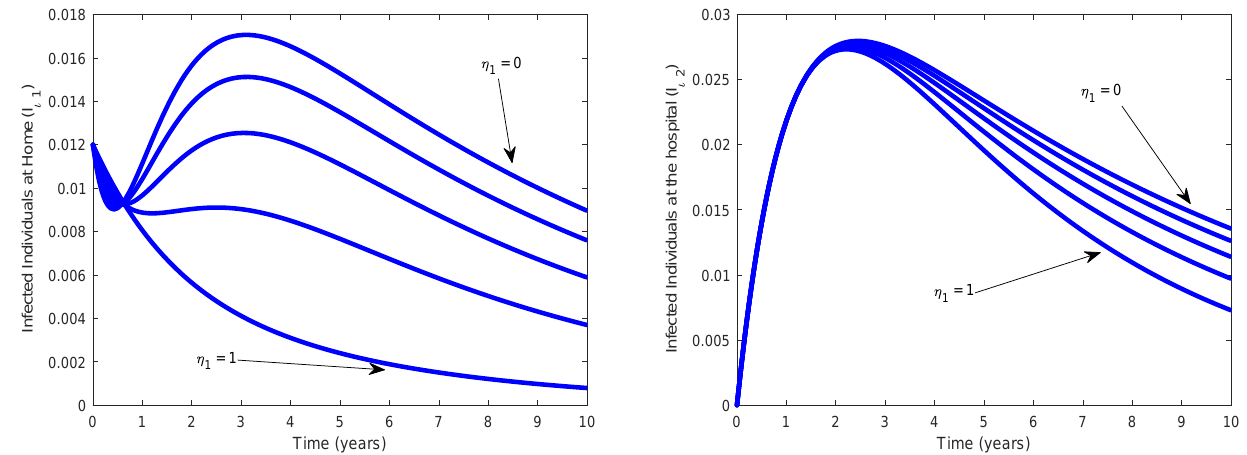
Figure 8. Impact of progression rate ( η 1 ) from I ι 1 to I ι 2 on I ι 1 , and I ι 2 , varying η 1 . Other parameters are given as Λ = 450,862, β = 0.86, ν = 0.25, φ = 0.2, σ = 0.65, z = 0.11, µ = 0.02041, ψ = 0.5, η 1 = 0.02, η 2 = 0.02, γ 1 = 0.5, γ 2 = 0.6, κ 1 = 0.03, κ 2 = 0.3, δ 1 = 0.2, δ 2 =